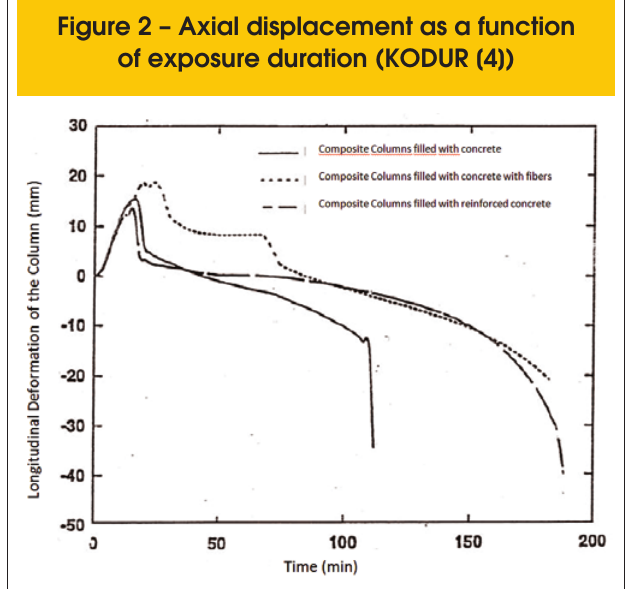
Figure 2 – Axial displacement as a function of exposure duration (KODUR